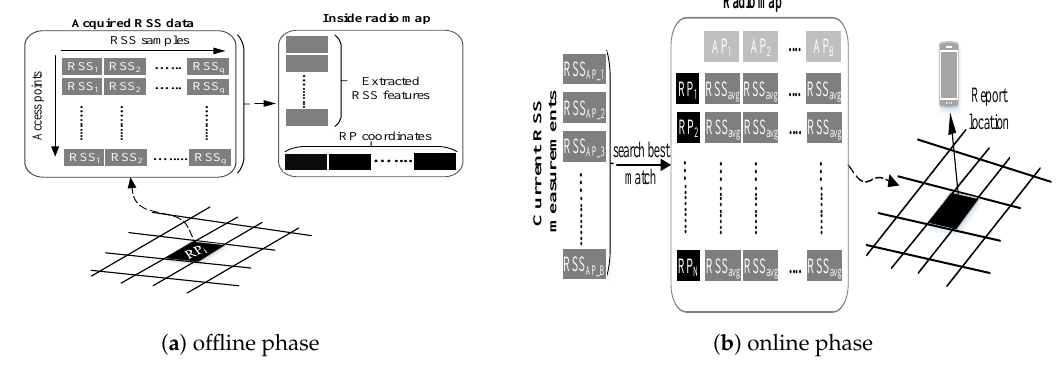
Figure 11. The working procedure of typical fingerprinting